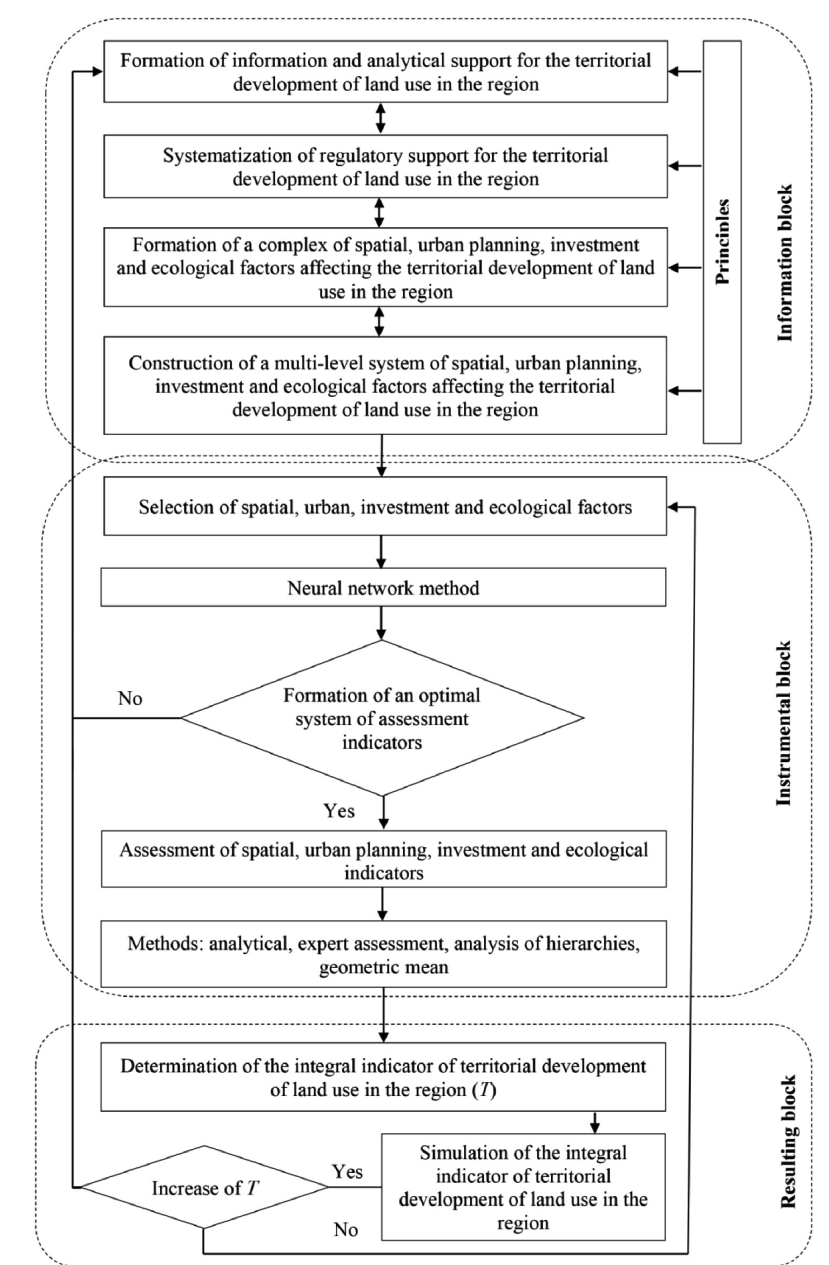
Figure 2. The algorithm for the development and implementation of a methodological approach to the integrated assessment of the territorial development of land use in the